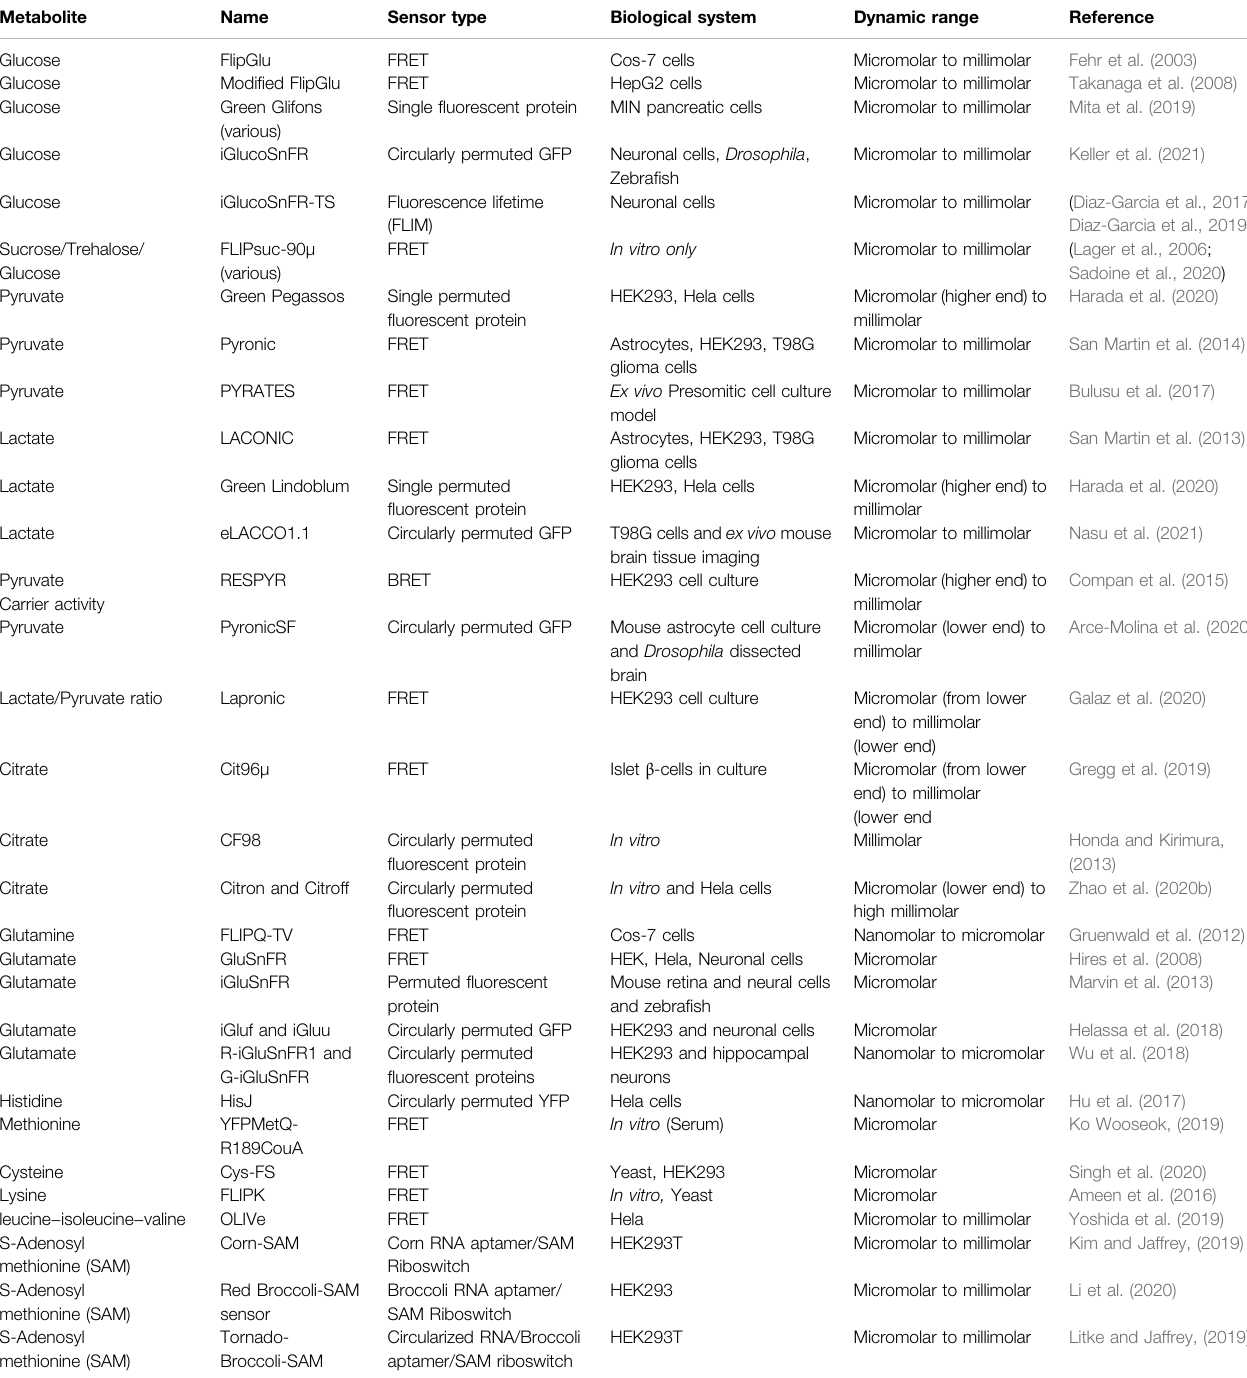
TABLE 1 | Listing of available biosensors for key